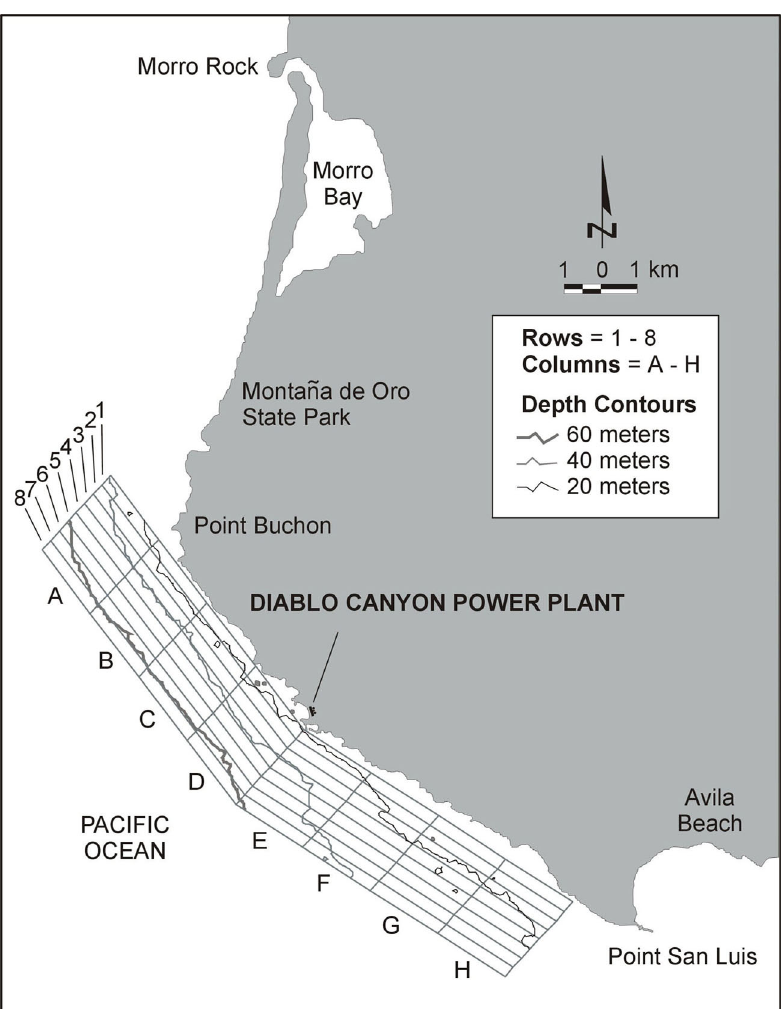
FIGURE 3. DCPP study grid and depth